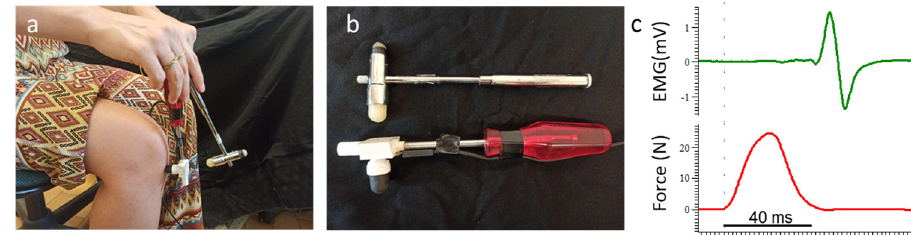
Figure 7. Measurement of percussive force stimuli: ( a ) the force sensor is interposed between the patellar tendon and the reflex hammer; ( b ) force sensor (bottom) and reflex hammer (top); ( c ) representative recordings of the patellar reflex: the electromyographic (EMG) response bipolarly recorded from the vastus medialis muscle and the delivered force stimulus (Force).